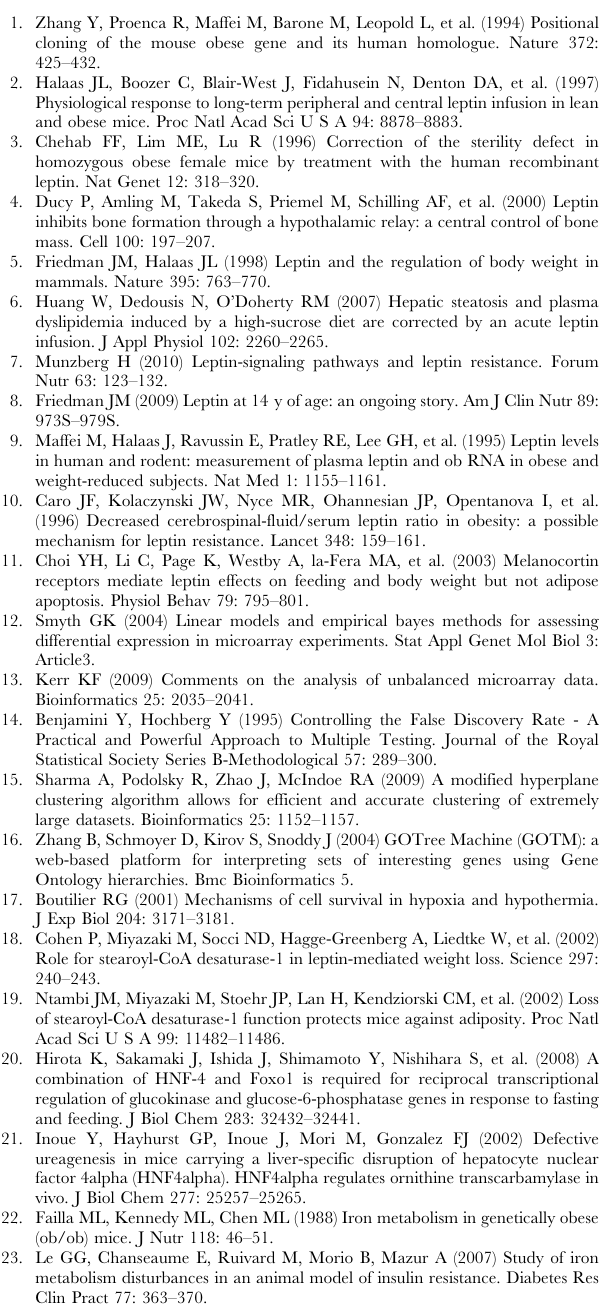
File S4 Networks.pdf. Top molecular networks and their biological functions affected by leptin treatment. Network analysis was performed using Ingenuity Pathway Analysis software.